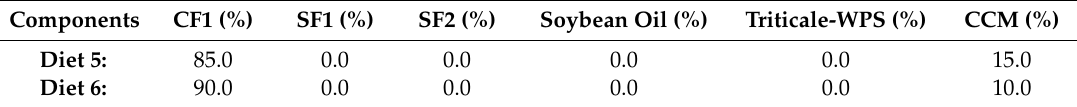
Table 3. Components given in Barn III to control group fed at an average bodyweight of 70 kg. Diet 5 was for the 50% lighter animals. Diet 6 was for the 50% of the heavier animals.